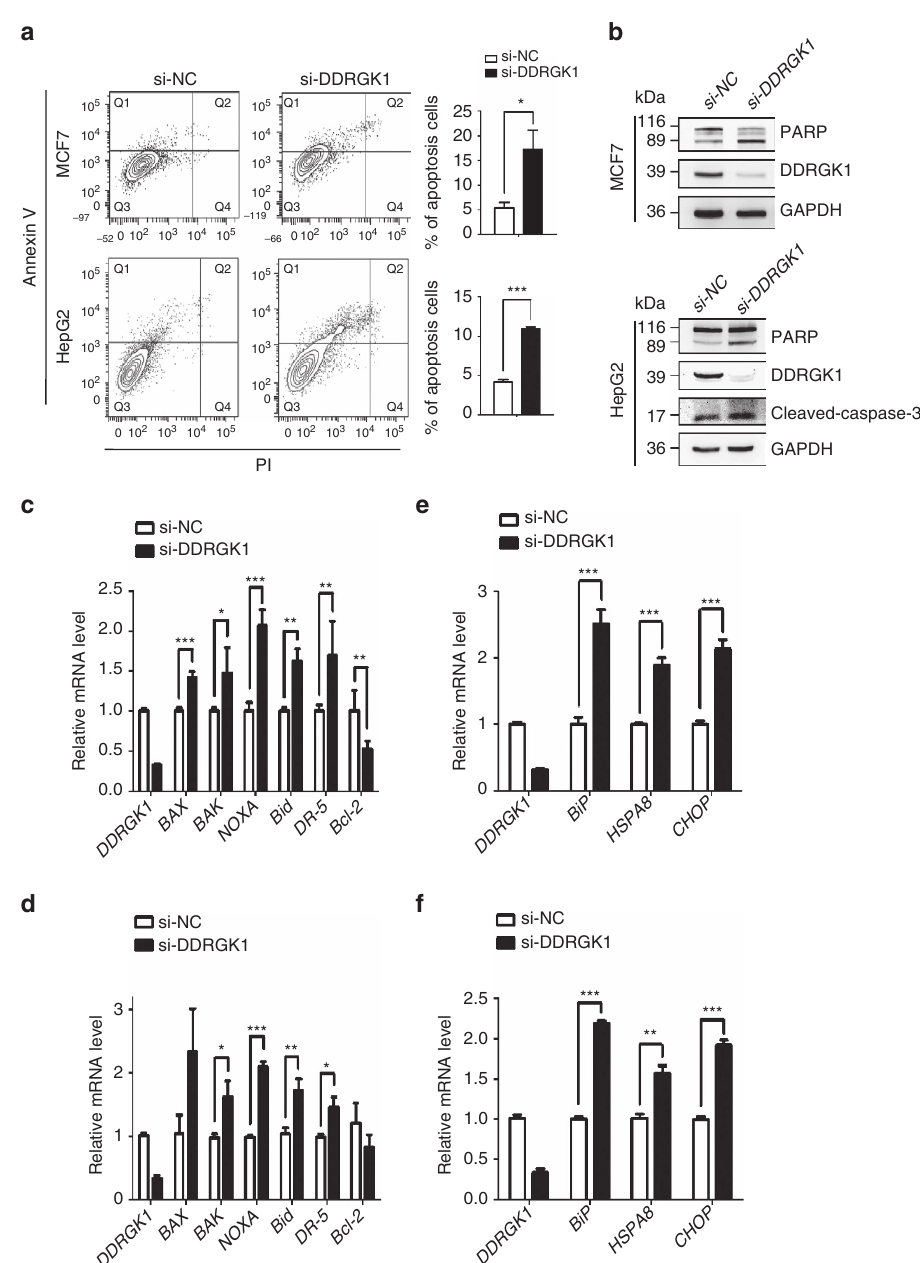
Figure 1 | Depletion of DDRGK1 leads to apoptosis and elevated ER stress. ( a ) MCF7 and HepG2 cells were transfected with either control siRNA or siRNA targeting DDRGK1 for 72h. The cells were subsequently stained with Annexin V and PI and subjected to flow cytometric analysis followed by the quantification of apoptotic cells (Annexin V þ ). ( b ) Western blot analysis of PARP and cleaved caspase-3 in control and DDRGK1-knockdown MCF7 and HepG2 cells described in a . ( c , d ) Q-PCR analysis of the relative mRNA expression levels of BAX , BAK , NOXA , Bid , DR-5 and Bcl-2 in control and DDRGK1- knockdown MCF7 and HepG2 cells. ( e , f ) Q-PCR analysis of the relative mRNA expression levels of BiP , HSPA8 and CHOP in control and DDRGK1-knockdown MCF7 and HepG2 cells. All data are presented as mean ± s.d. from three experiments. * P o 0.05, ** P o 0.01 and *** P o 0.001 by Student’s t